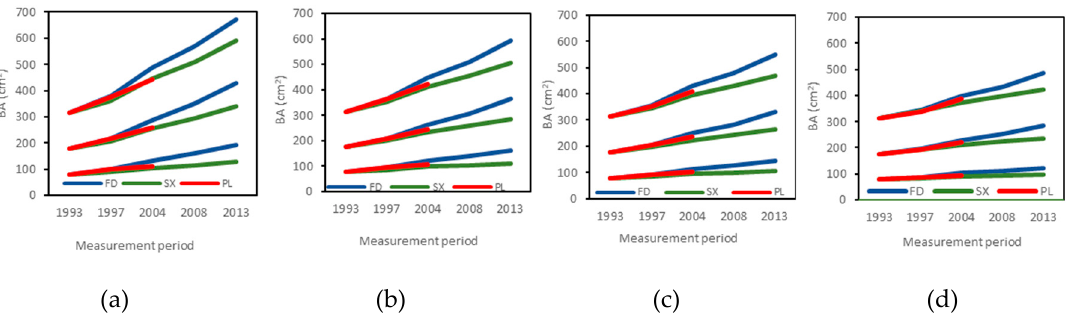
Figure 4. BA (cm 2 ) projections in each measurement period for interior Douglas-fir (FD), spruce (SX), and lodgepole pine (PL) starting in 1993 at a 10 cm DBH (lowest set of lines), 15 cm DBH (middle set of lines), and 20 cm DBH (highest set of lines) under ( a ) no competition, ( b ) 10th percentile of competition, ( c ) 50th percentile of competition, and ( d ) 90th percentile of competition.